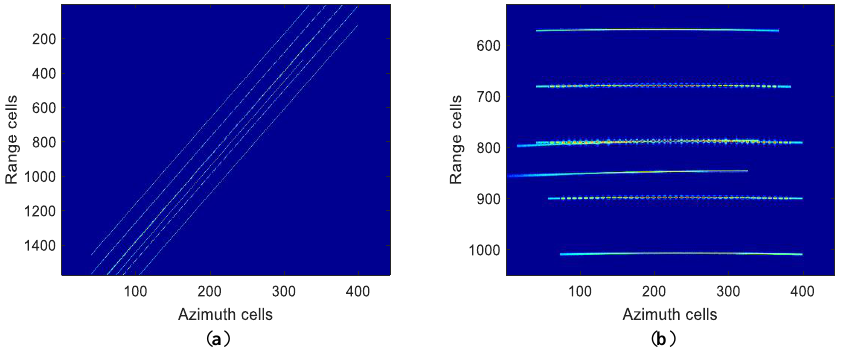
Figure 11. The results before ( a ) and after ( b ) coarse